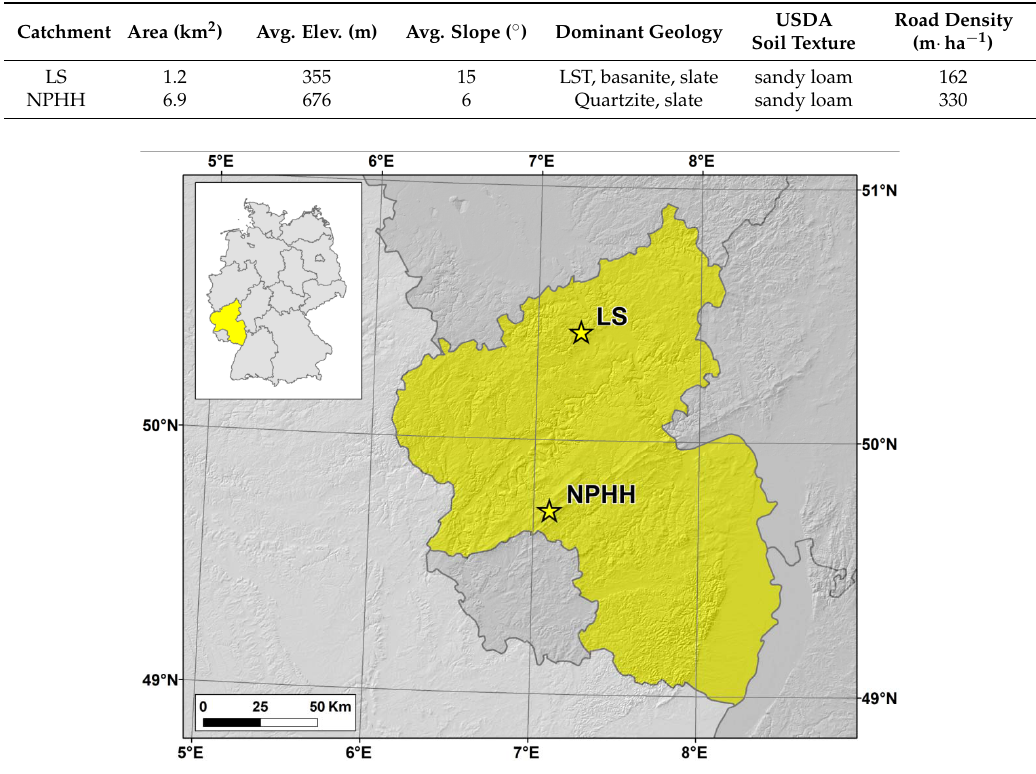
Figure 1. Localization of the study areas Laacher See (LS) and national park Hunsrück ‐ Hochwald